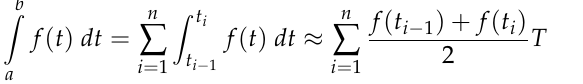
Figure 6. FFT (magnitude) response of the FIR low-pass filter designed in MATLAB ®® and imple- mented in the FPGA. Figure 7 shows the input and output signals of the embedded system for a modulated signal of 200 Hz. Figure 7a shows the input interferogram 𝐼(𝑡) . In addition, a comparison between the output signal and the modulated signal 𝜑(𝑡) = 0.75 cos(2𝜋 × 200𝑡) is shown in Figure 7b. To change the units from radians to meters, both signals are scaled to 𝜆 4𝜋 . Figure 7. ( a ) Input interferogram for a modulated signal of 200 Hz. ( b ) Comparison between the modulated signal and the output signal of the embedded system, after demodulation process and scaled to 𝜆 4𝜋 .